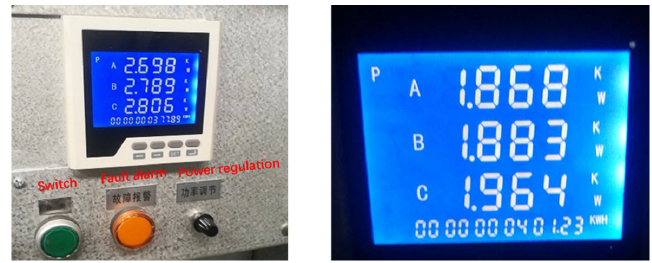
Figure 15. Three-phase power change of control box.